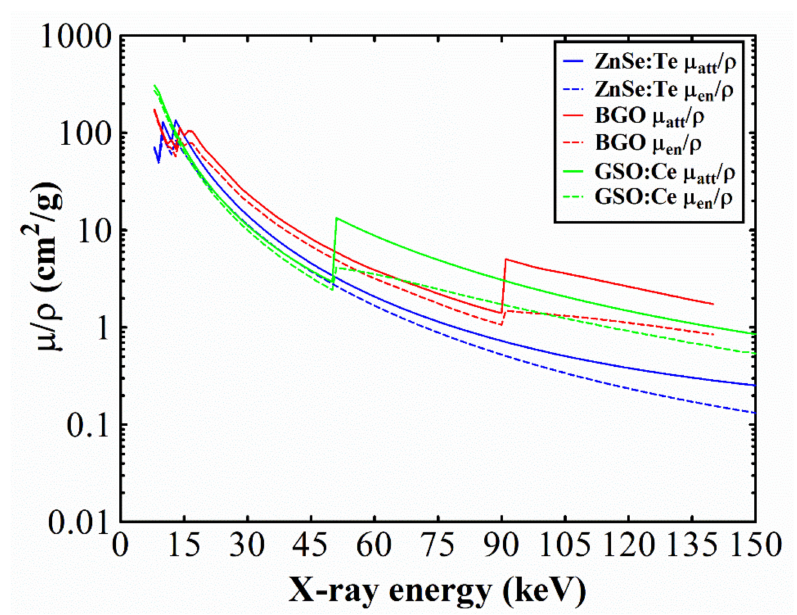
Figure 2. Attenuation coe ffi cients of ZnSe: Te, BGO and GSO: Ce.